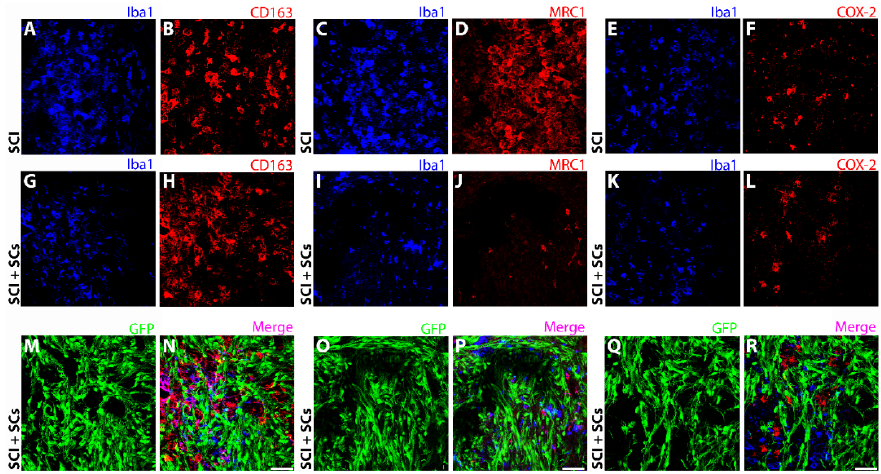
Figure 8. CD163, MRC1, and COX-2 immunoreactivity was unchanged with SC transplantation though lesional and perilesional disparities were observed. Immunoreactivity for CD163 (red) was similar among SCI control ( A , B ) and EGFP-SC-transplanted (green) ( G , H , M , N ) animals, while MRC1 (red) did show a reduction in immunoreactivity from the SCI control ( C , D ) within the lesion–SC implant ( I , J , O , P ) but not overall. No change in the immunoreactivity for COX-2 (red) was seen between SCI control ( E , F ) and EGFP-SC transplant groups ( K , L , Q , R ). Total innate immune cells identified using Iba1 (blue). Triple staining of EGFP, Iba1 and CD163, MRC1 or COX-2 are shown in the merged images (pink; ( N , P , R )). Iba1 Images were acquired at 40 × objective magnification. Scale bar = 50 µ